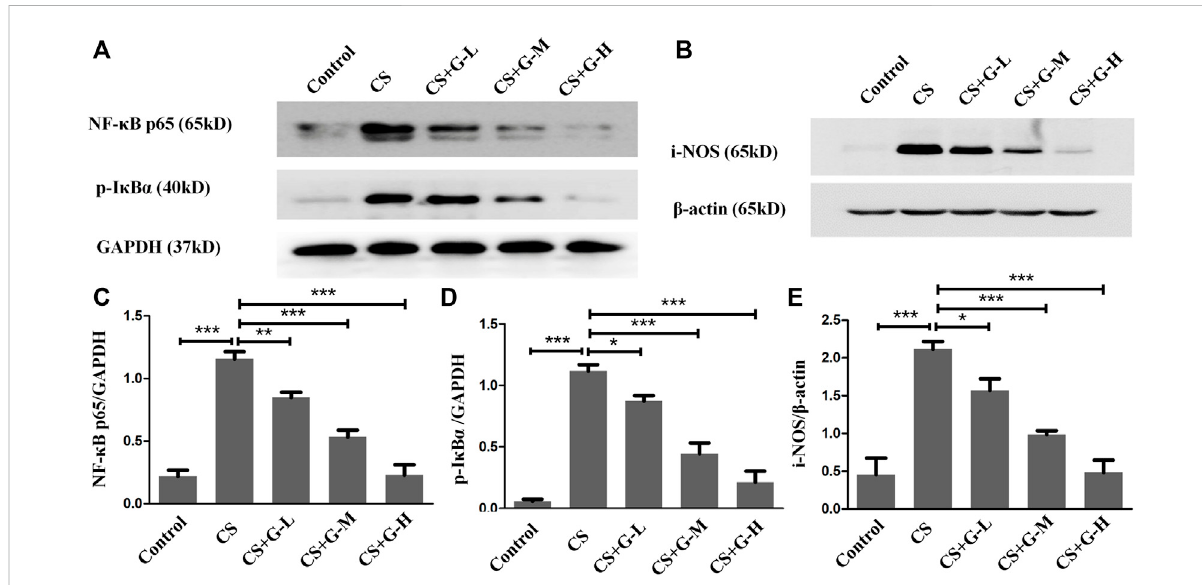
FIGURE 5 GHK-CupreventedtheactivationofNF- κ Bandi-NOSinducedbycigarettesmoke. (A,B) TheexpressionofNF- κ Bp65,p-I κ B α andi-NOSinlung tissue in mice from different groups was assessed by western blotting. (C – E) Western blotting analysis of NF- κ B p65 (C) , p-I κ B α (D) and i-NOS (E) expression in the lung tissue of mice from different groups. * p < 0.05, ** p < 0.01 and *** p <